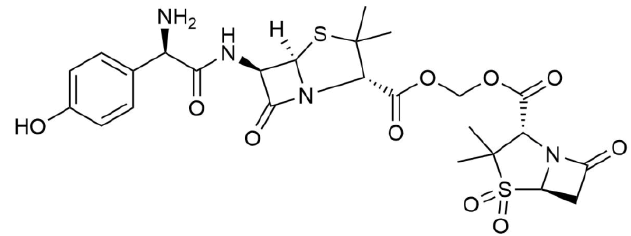
Figure 1. Chemical structure of AS.